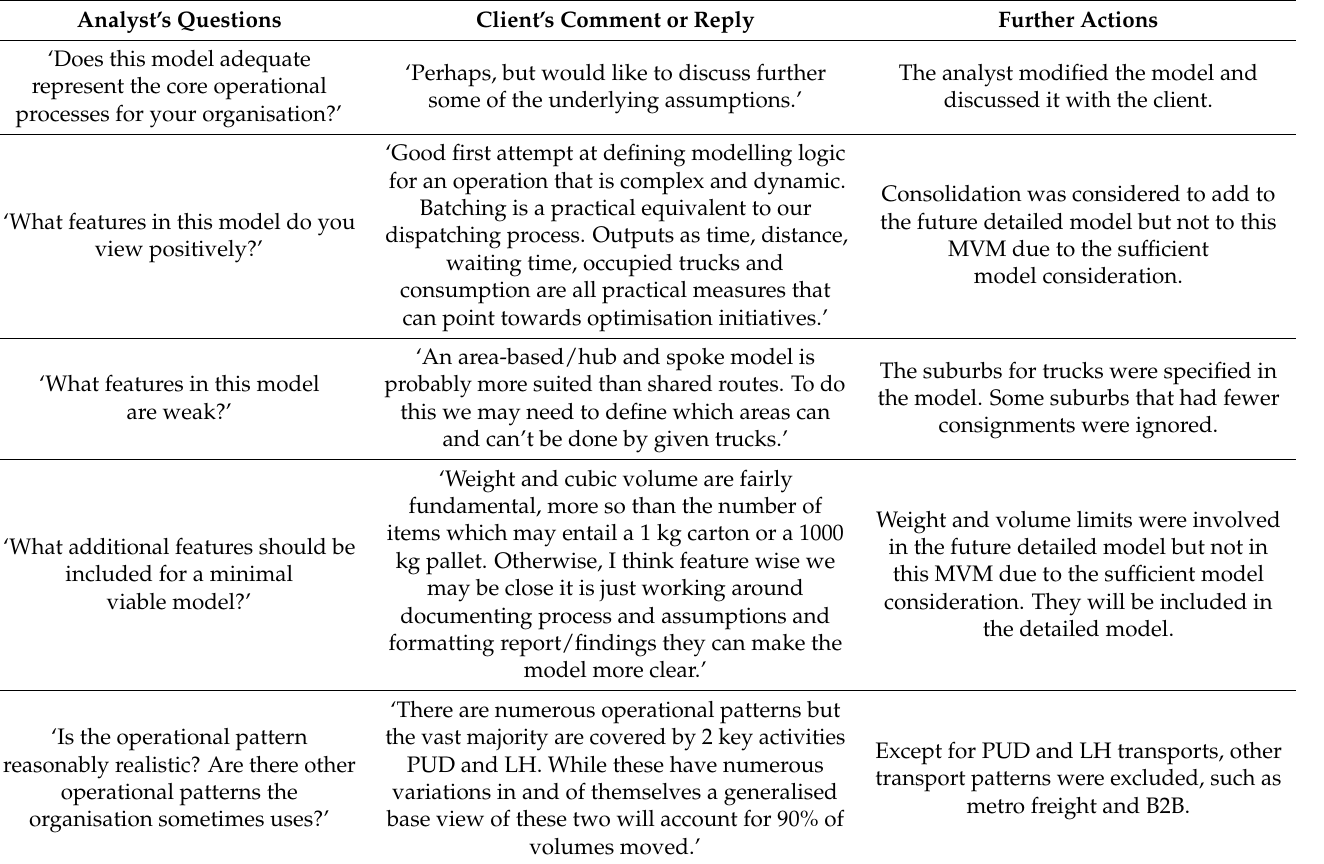
Table 3. Example of interactive face